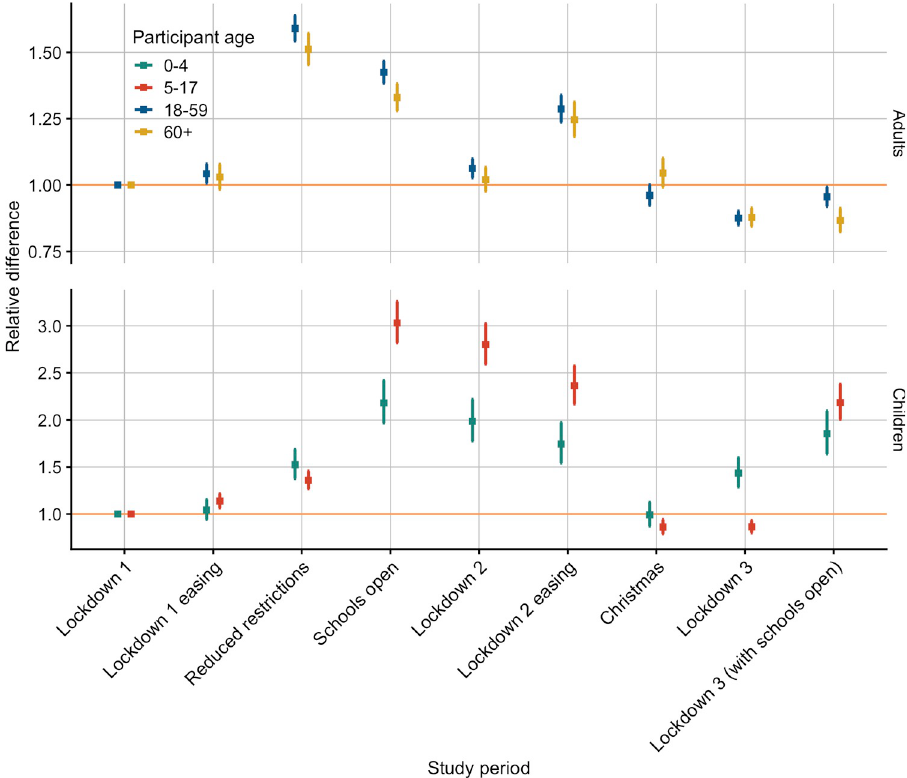
Fig 2. Relative difference in mean contacts by study period and age group with 95% CIs. Relative differences calculated using a GAM with Lockdown 1 as the reference period for each age group adjusted to the UK population by age and gender (when available) for the age groups 0 to 4, 5 to 17, 18 to 59, and over 60 years old. Note the facets have different scales on the y-axes. Table 1 provides corresponding dates for each study period. CI, confidence interval; GAM, generalised additive